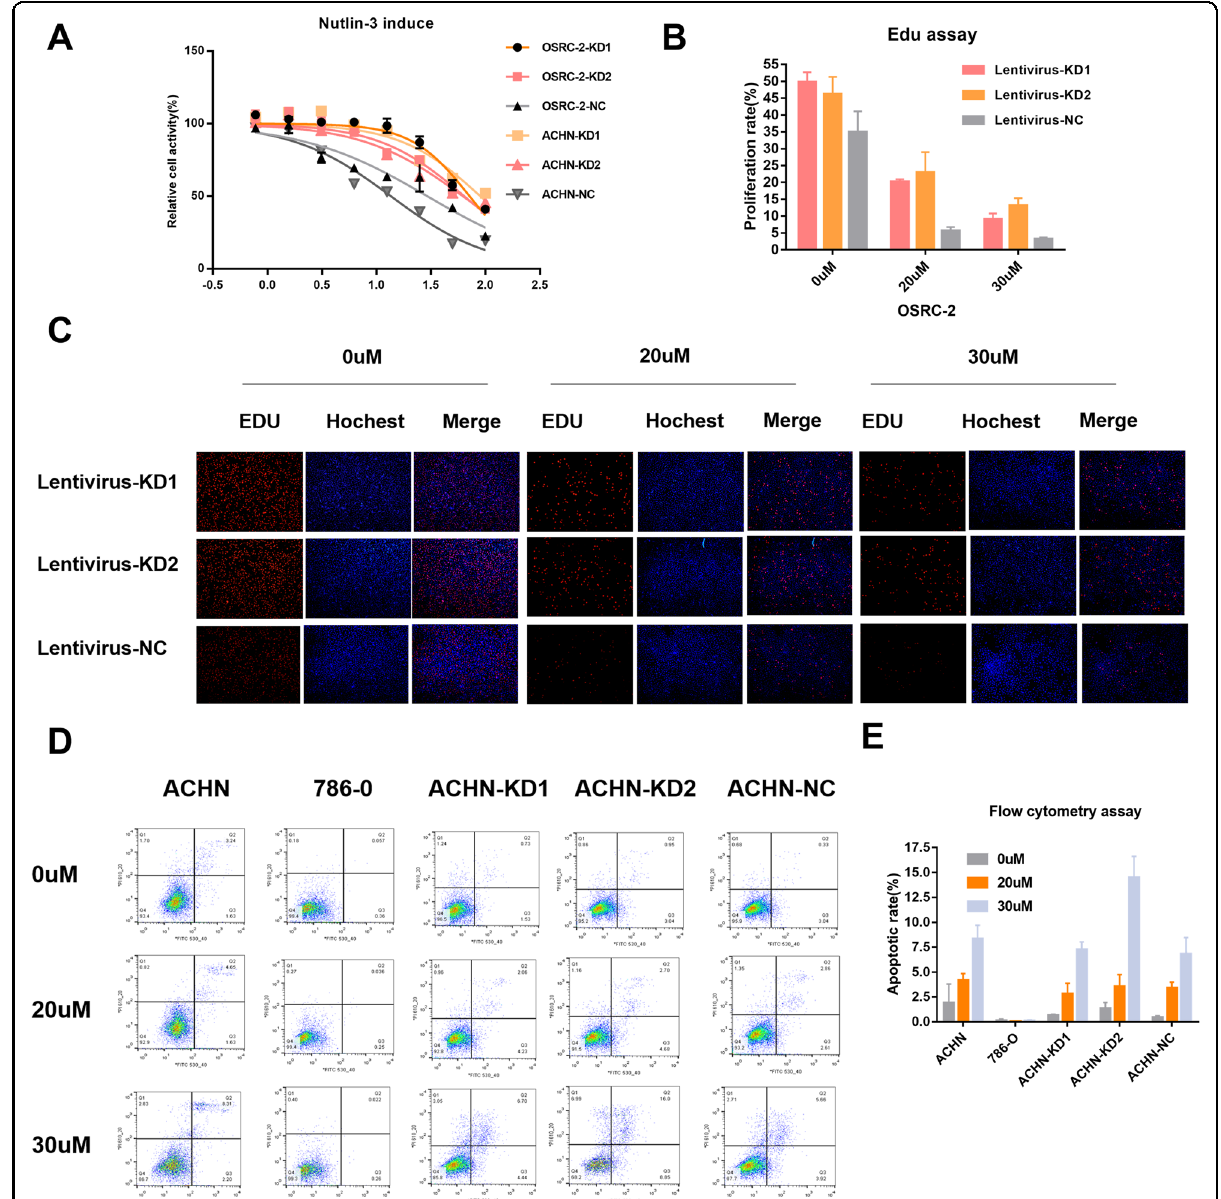
Fig. 3 P53BER2 could mediate p53-related function in TP53-WT renal cancer cell lines. A The relative cell activity of different stable RCC cell lines after nutlin-3 treatment. B , C The proliferation rate of OSRC-2 stable cell lines infected amicroRNA or vector after nutlin-3 treatment by EDU assay, scale bar, 100 μ m. D , E The apoptotic rate of different RCC cell lines or stable cell lines after nulin-3 treatment. Results are shown as mean ± SD. *** P < 0.001 compared with control. ** P < 0.01 compared with control. * P < 0.05 compared with